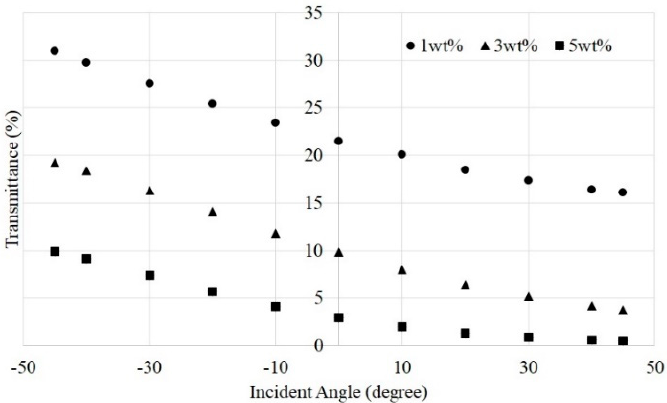
Figure 9. Transmittance dependences on the incident angles for HAN-LCDs using LC materials containing 1, 3, and 5 wt.% of NKX-4173 (Hayashibara Ltd. Japan) dichroic dye with a polarizer. The optical axis of a polarizer is parallel to the alignment direction of the HAN-LCD.